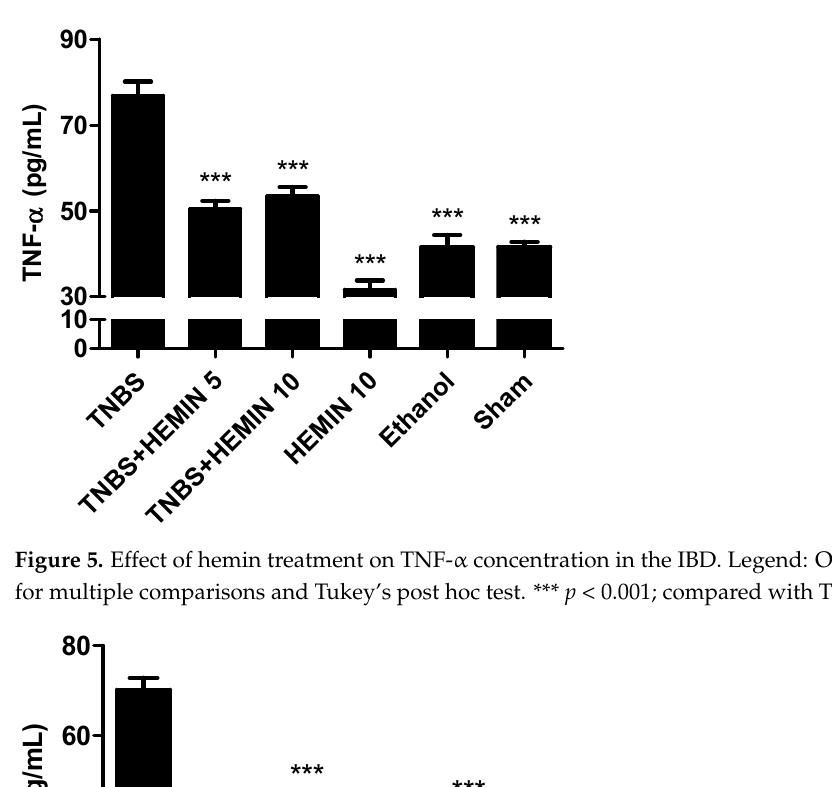
Figure 5. Effect of hemin treatment on TNF- α concentration in the IBD. Legend: One-way ANOVA for multiple comparisons and Tukey’s post hoc test. *** p < 0.001; compared with TNBS group.